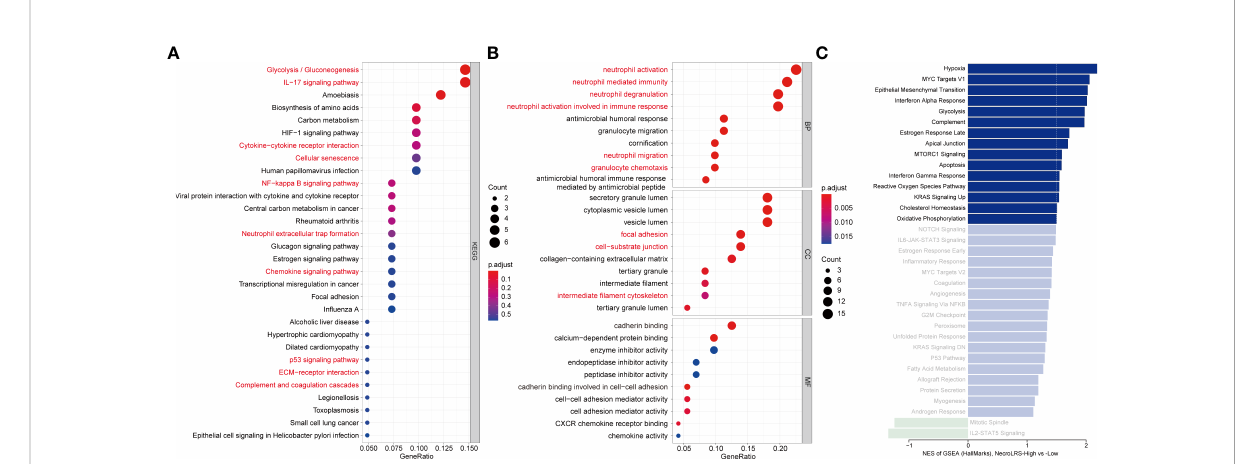
FIGURE 8 Single-cell RNA-seq-based enrichment analysis. (A) KEGG analysis based on marker genes in the NecroLRS-High subcluster. (B) GO analysis based on marker genes in the NecroLRS-High subcluster. (C) GSEA analysis based on differentially expressed marker genes among NecroLRS- related subclusters. Bars corresponding to pathways that meet absolute NES > 1.5 are colored in the bar diagram, while others are shown in unsaturated